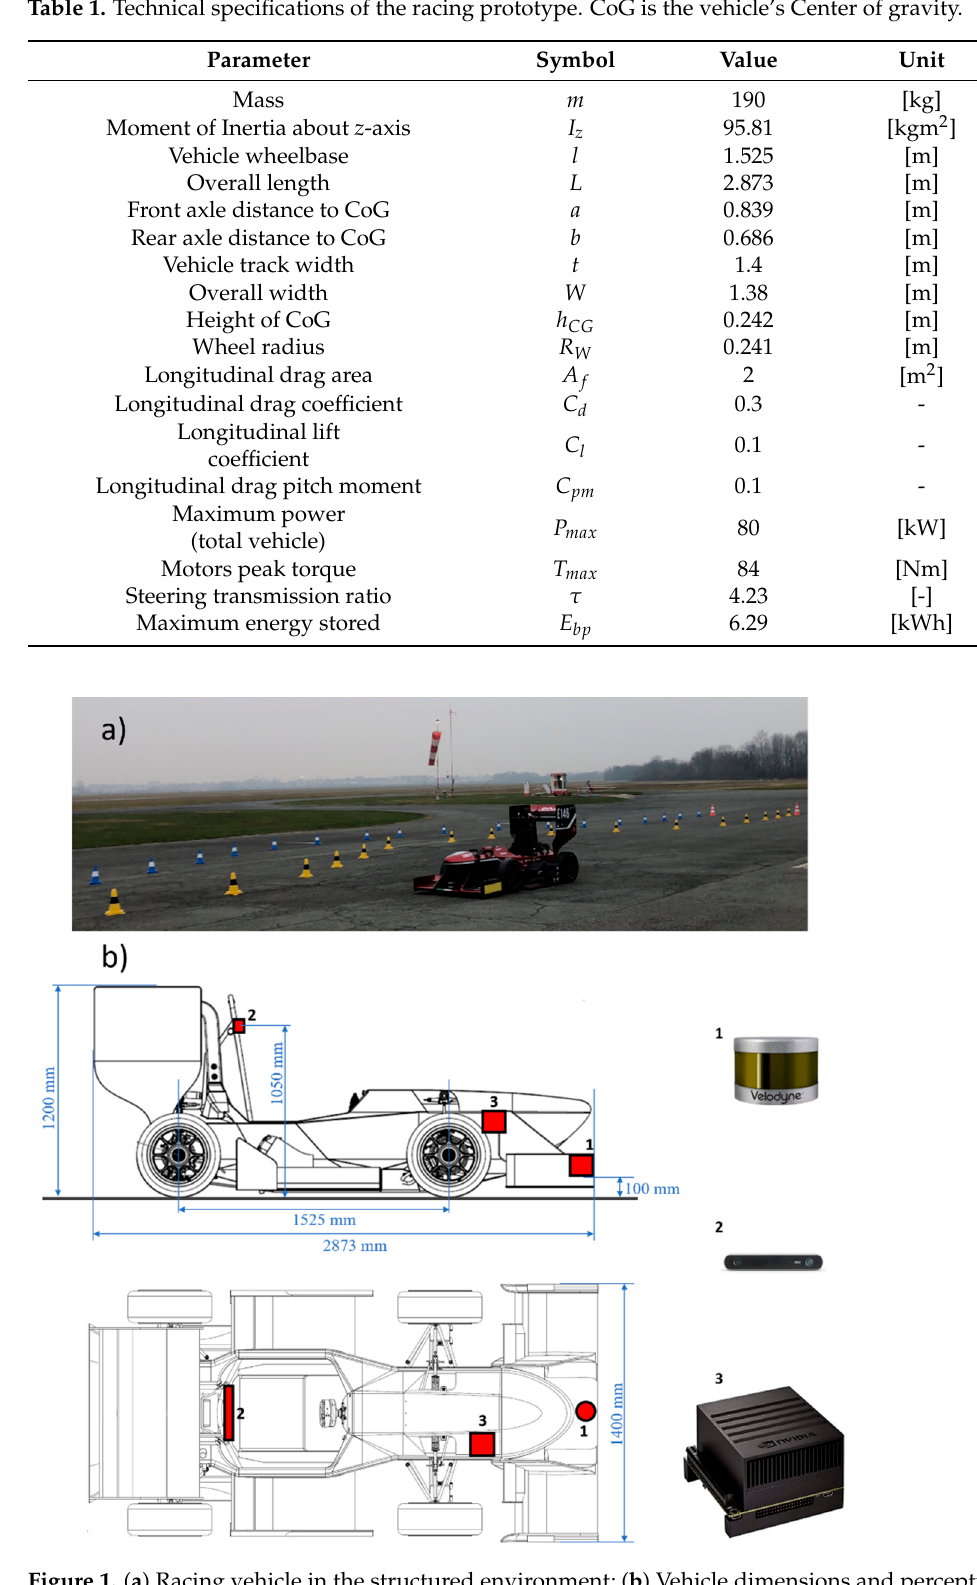
Table 1. Technical specifications of the racing prototype. CoG is the vehicle’s Center of gravity.